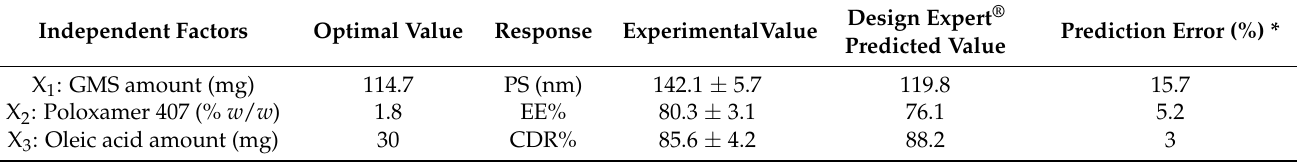
Table 3. Composition, experimental, and Design Expert ® predicted values of the optimal BER-CTS- NLCs formulation.